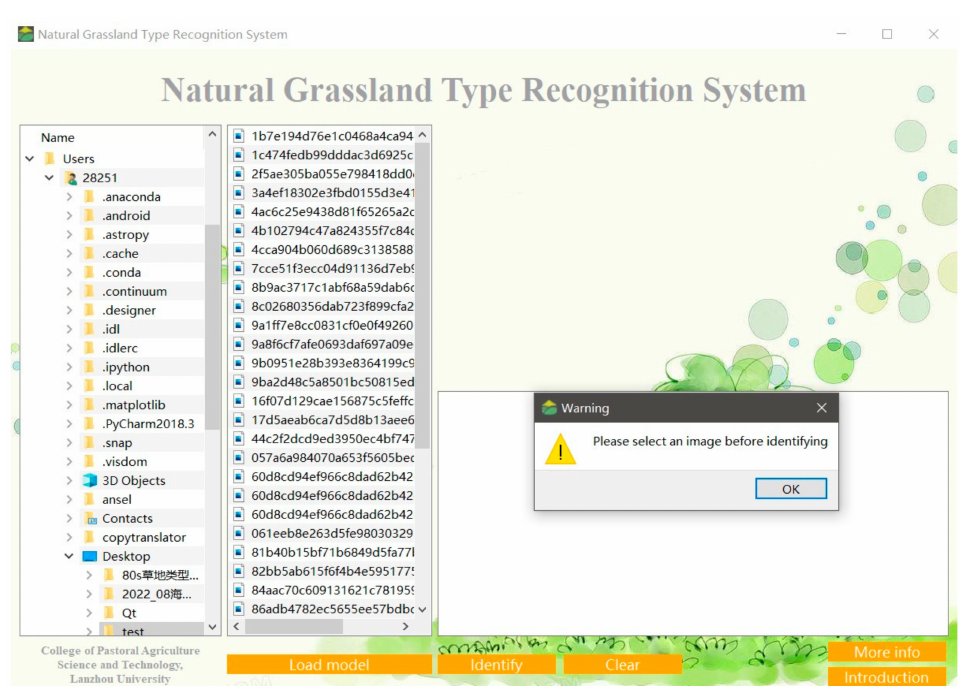
Figure 10. Prompt window example in the grassland-type recognition system.